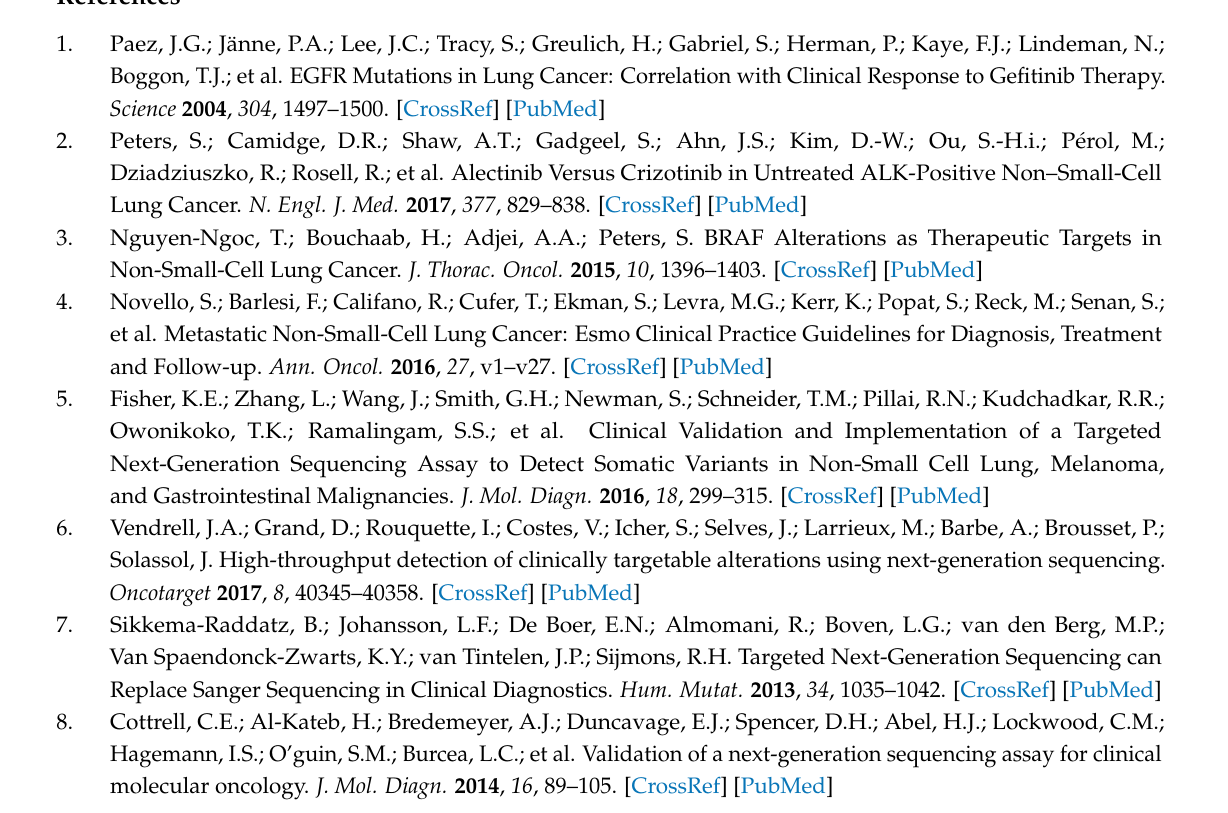
Figure S1: For one Sample, DNA Isolation and Sequencing was repeated 4 times. Allele Frequency of the KRAS p.Q61H mutation after repeated sequencing using the GeneReader and Ion PGM was determined to assess reproducibility of the assay; Figure S2: Comparison of the coverage between the GeneReader and the PGM in the A retrospective and the B prospective cohort. Coverage at the site of the mutation in the PGM is plotted against the coverage at the site of mutation for the GeneReader. The Pearson’s correlation is indicated on the graphs. The 95% confidence interval is represented as hatched grey areas. Different mutations are represented in different colored dots as mentioned on the graph; Table S1: Description of Patient cohort; Table S2: Comparison of detected alterations between the two sequencing systems by type of